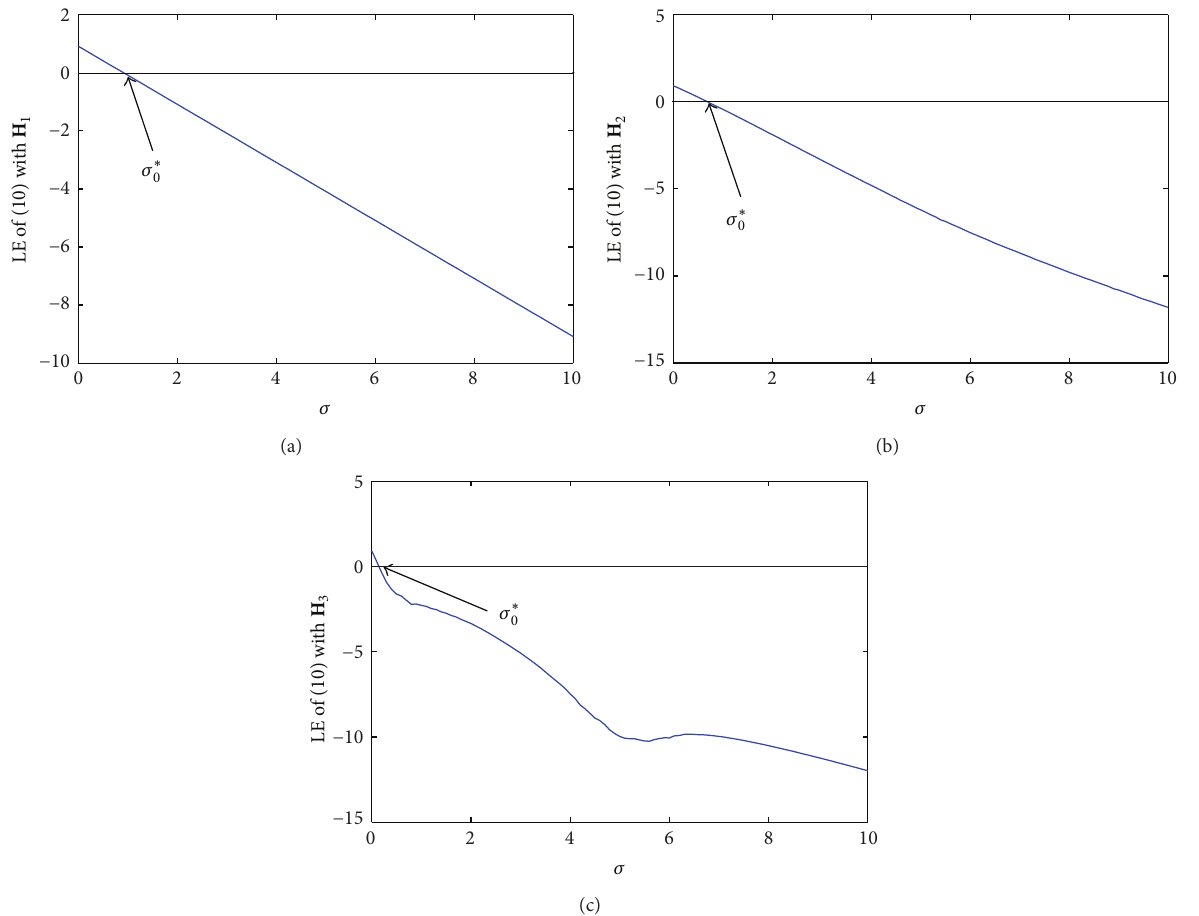
Figure 3: 𝑋 label: 𝜎 = −𝑐𝜆 , 𝑌 label: Lyapunov Exponent of network (13), single node dynamics: Lorenz system, inner-coupling matrix: H 1 (a); H 2 (b); H 3 (c). The cross point 𝜎 ∗ 0 represents the lower bound of synchronous region in each